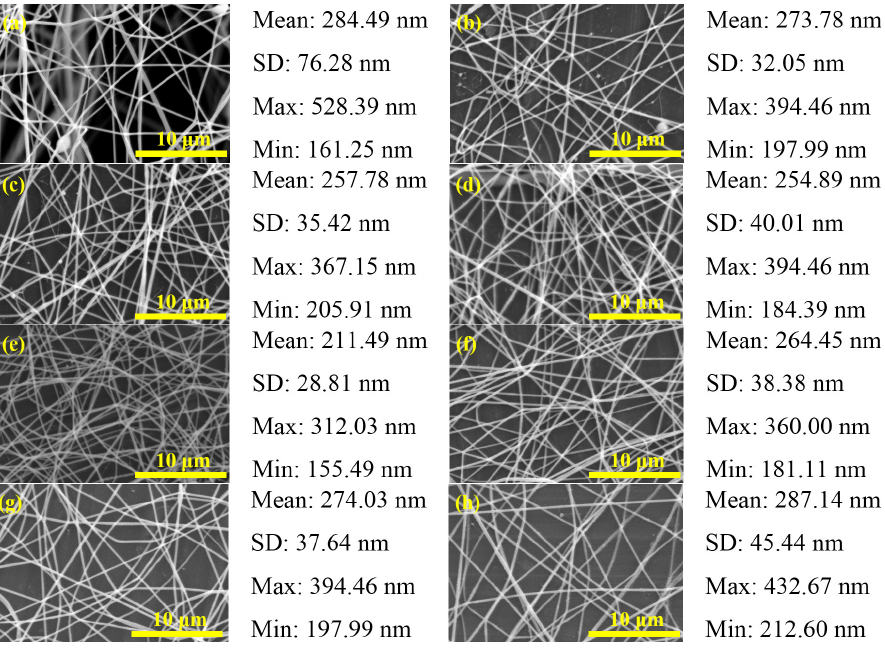
Figure 6. SEM images of PbI 2 /PVP composite fibers produced at different spinning distance: ( a ) 2; ( b ) 4; ( c ) 6; ( d ) 8; ( e ) 10; ( f ) 12; ( g ) 14 and ( h ) 16 cm (V = 16 kV, FR = 1.0 mL/h).